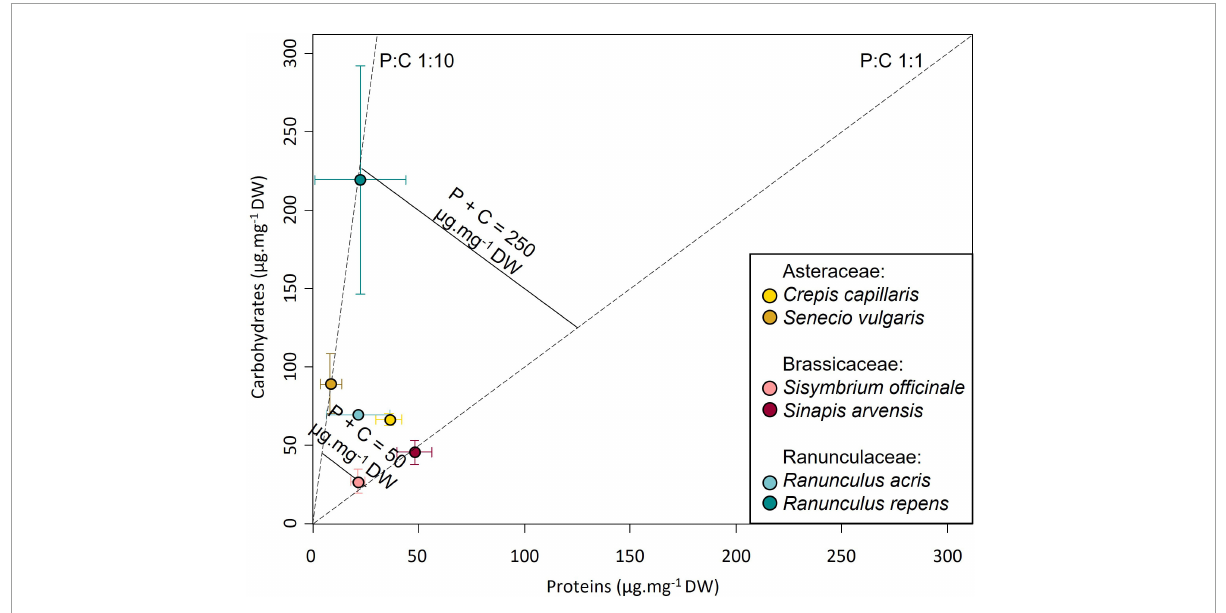
FIGURE3 Host plant positions in the macronutrient